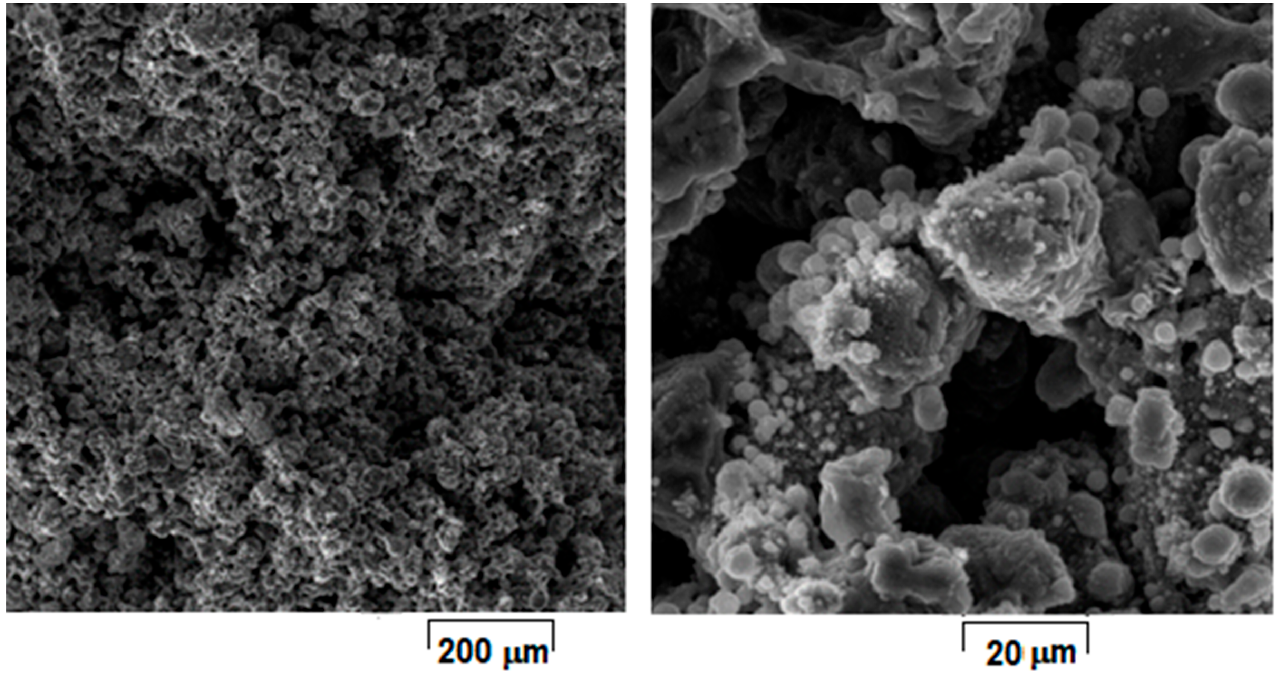
Figure 4. SEM-SE images of L-PBF sample obtained with laser power 180 W; scanning speed 700 mm/s; layer height 20 μ m applied parameters and calculated laser energy density 429 J/mm 3 .